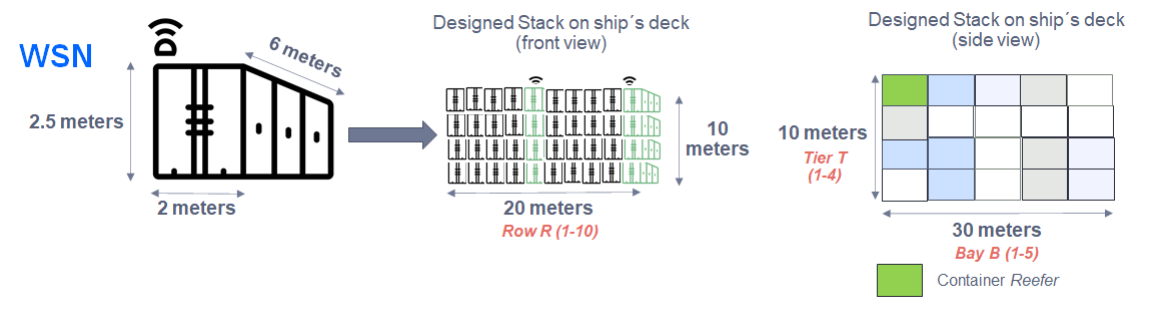
Figure 3. WSN subsystem scheme.